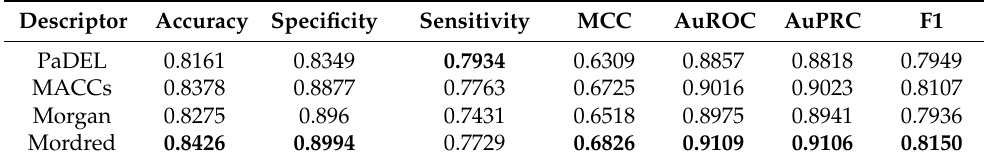
Table 3. Comparison of Different Feature Descriptors. (Bold values represent high